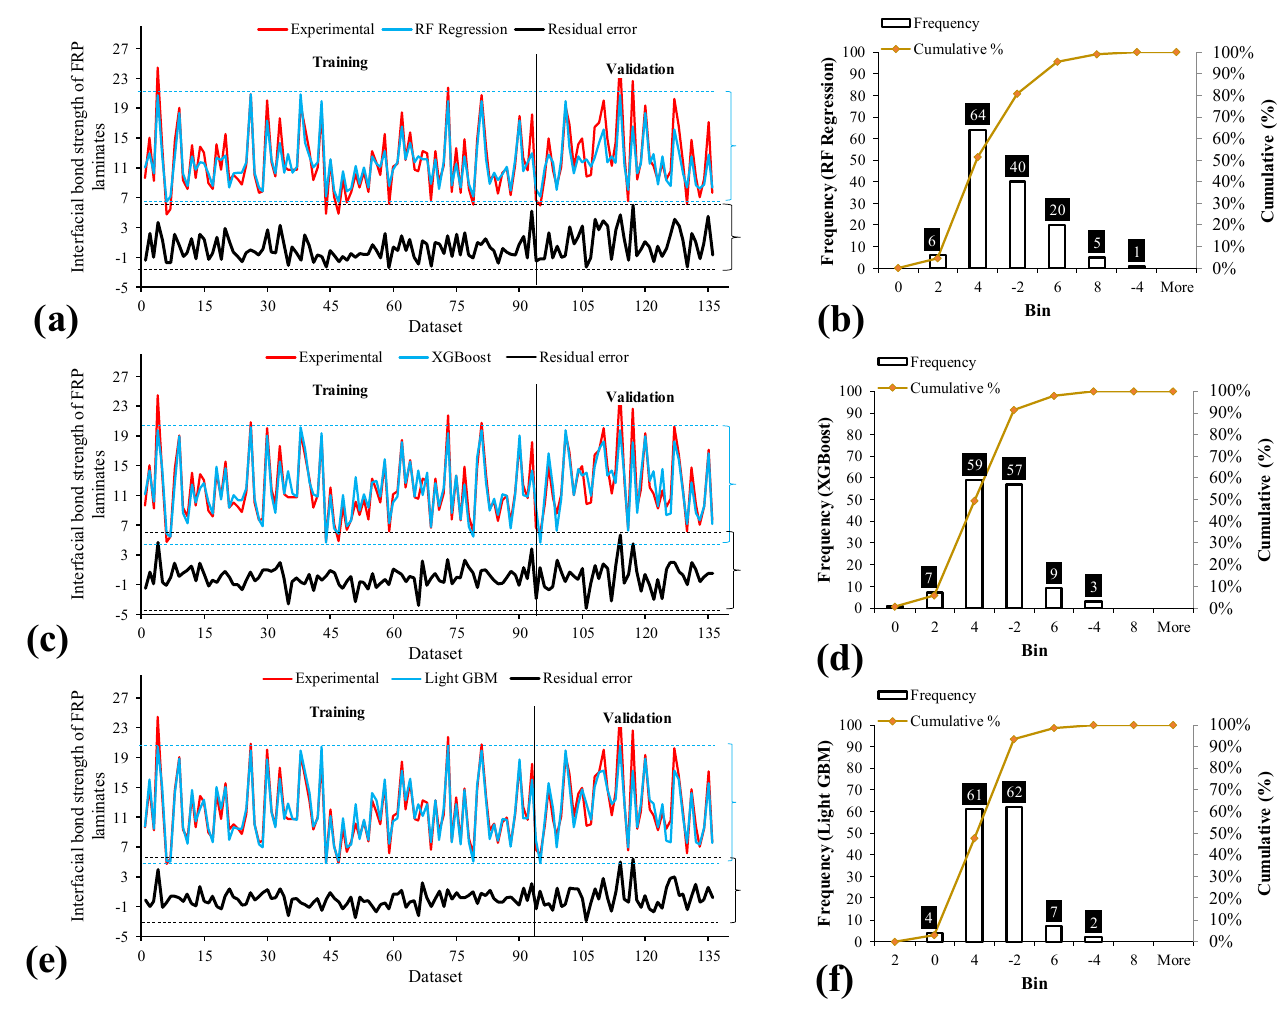
Figure 4. Tracing of experimental results by the prediction: ( a ) RF, ( c ) XGBoost, ( e ) LIGHT GBM and experimental to predicted ratio of: ( b ) RF, ( d ) XGBoost, ( f ) LIGHT GBM.